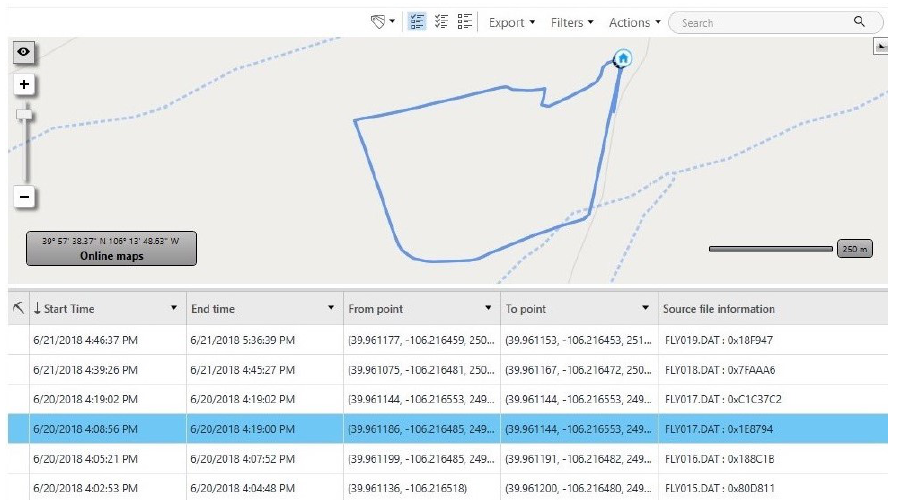
Figure 5. A visualization map of the 946 waypoints recovered by Cellebrite.